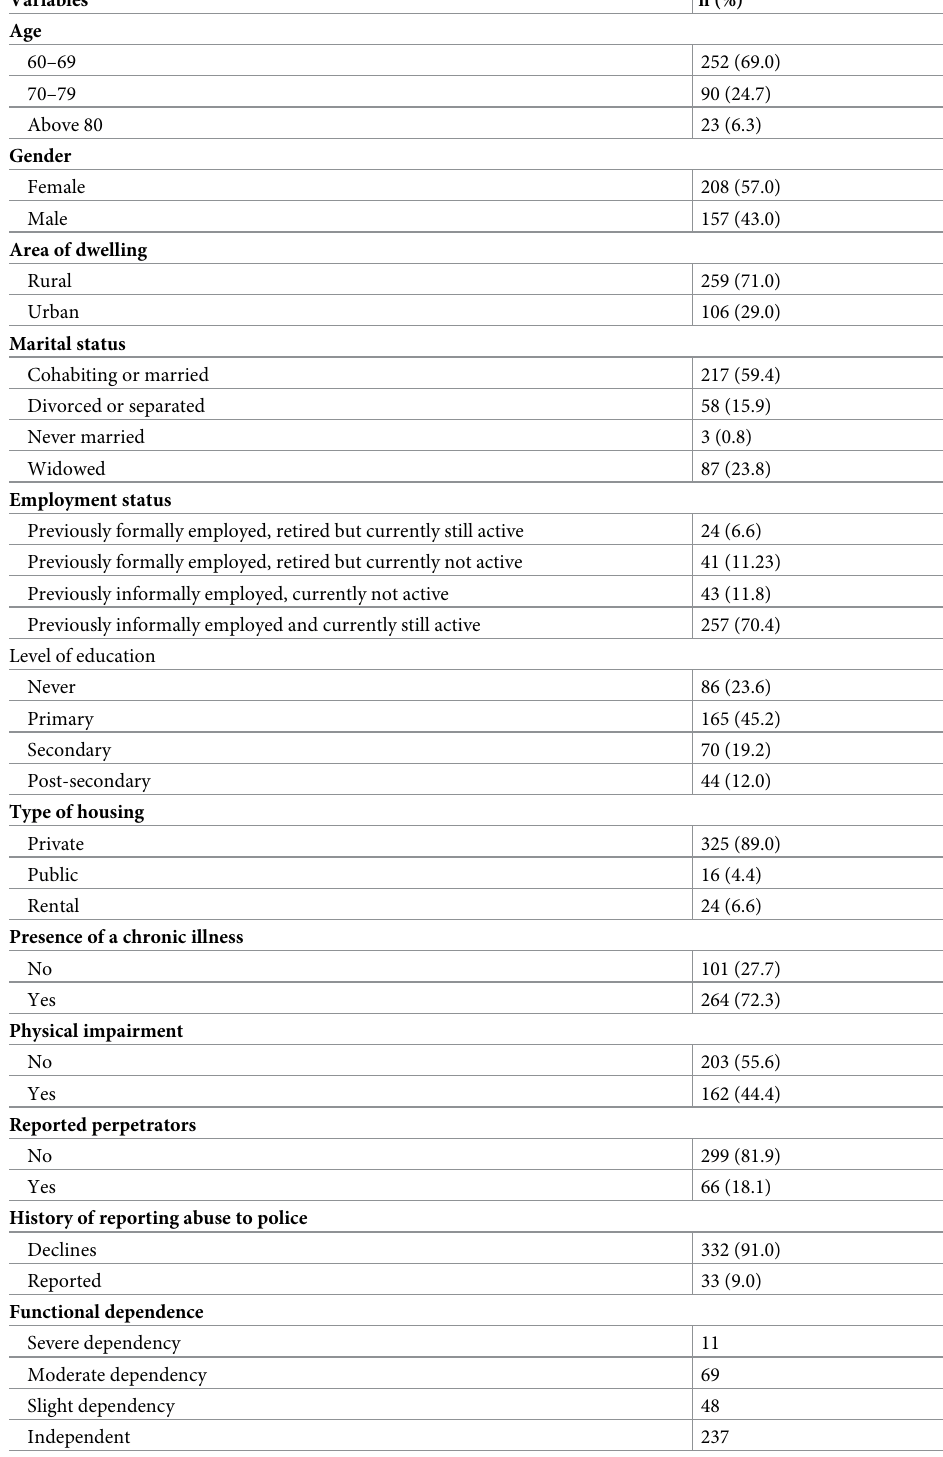
Table 1. Characteristics of the